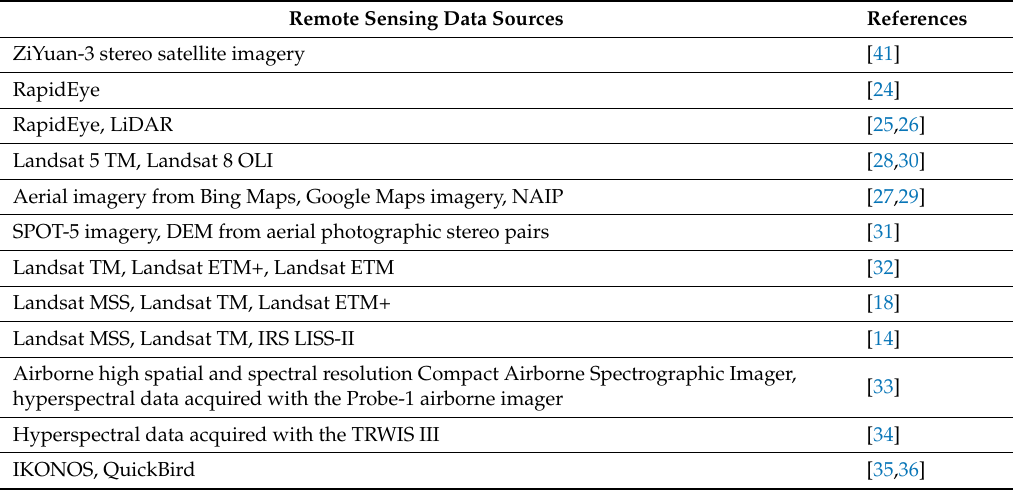
Table 2. Remote sensing data